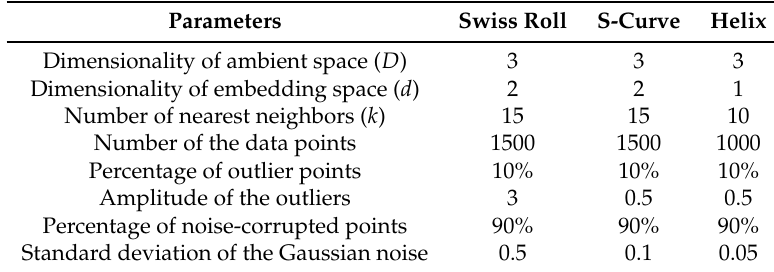
Table 1. Parameter settings of the synthetic data experiments.